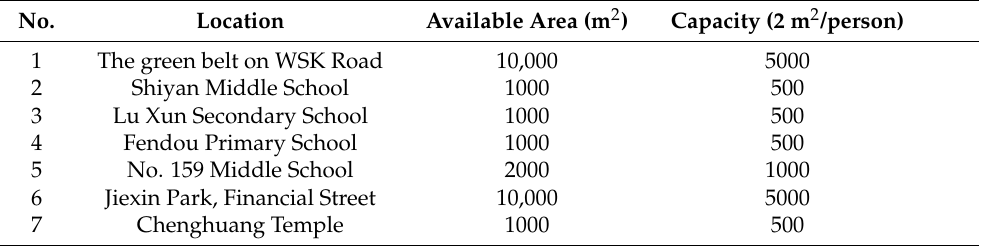
Table 2. Statistical table of shelters in open